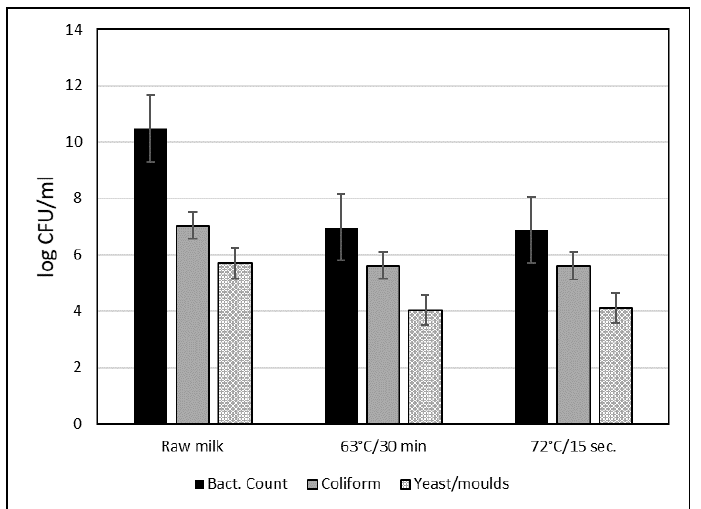
Figure 1. Changes in total bacterium, coliform, and yeast/mold count in camel milk before (raw) and after heat treatment (from [75]).